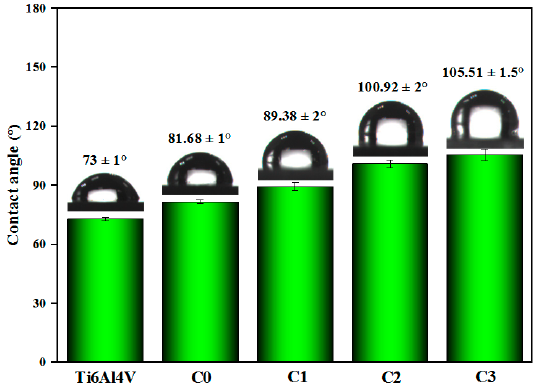
Figure 9. Contact angle value and water droplet photo of coated and uncoated samples.